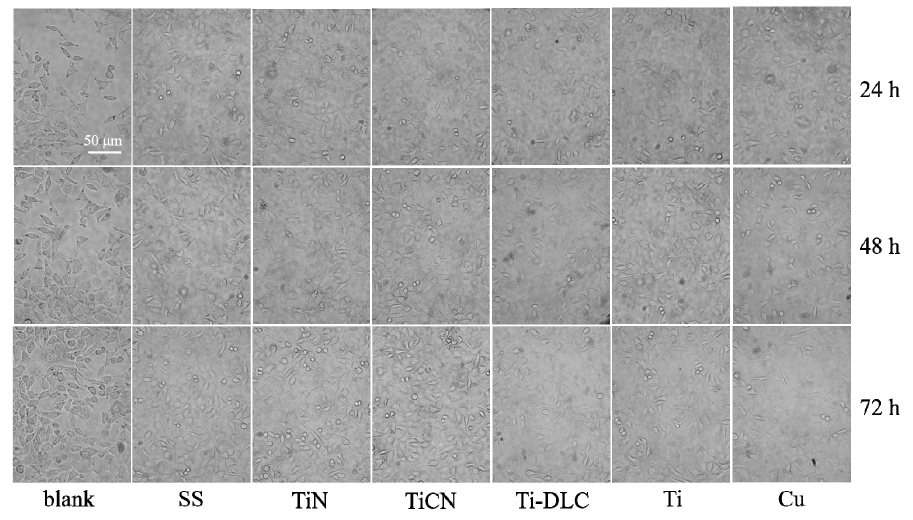
Figure 4. Morphology of L929 cells for the samples after 24, 48, and 72 h of incubation.